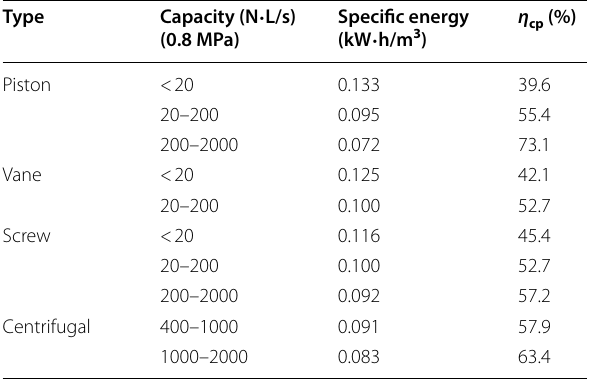
Table 4 Some typical compressor features Table 5 K